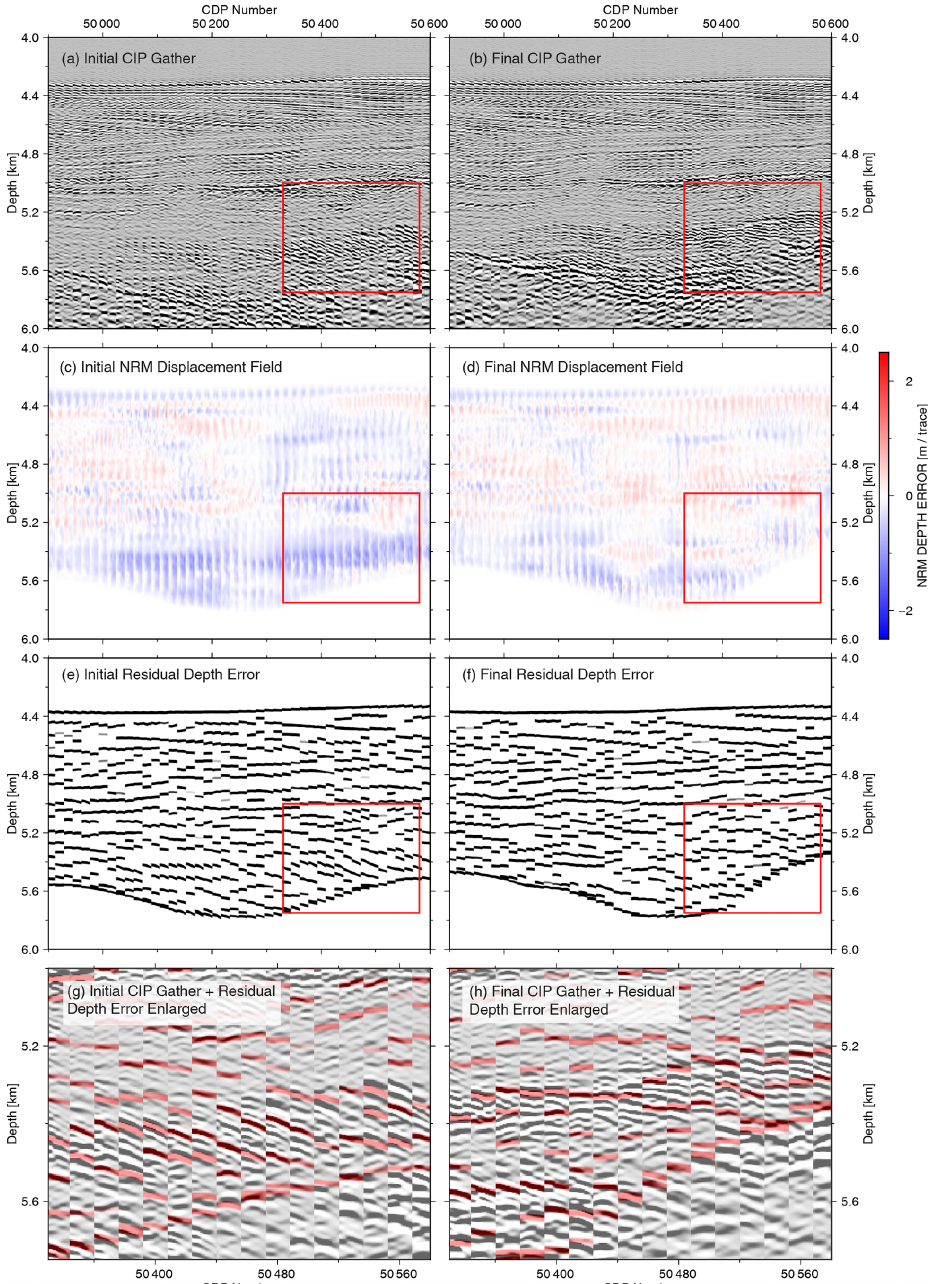
Figure 8. NRM velocity updating of Fig. 7 in CIP domain. (a) CIP gathers based on the initial velocity model. (b) CIP gathers based on the final velocity model. (c) Initial NRM depth shifts in the CIP domain. (d) Final NRM depth shift in CIP domain. (e) RMO picks calculated from the initial NRM displacement field. (f) RMO picks calculated from the final NRM depth displacement field. Note that the overall shift error within the distinct area of velocity overestimation in the red rectangle in (c) has been substantially reduced after the tomography (d) . CIP gathers (e) and (f) of the red rectangle from (c) and (d) respectively overlaid by RMO picks. Strong dipping events in the initial CIP gather (g) have been flattened after the final iteration (h)